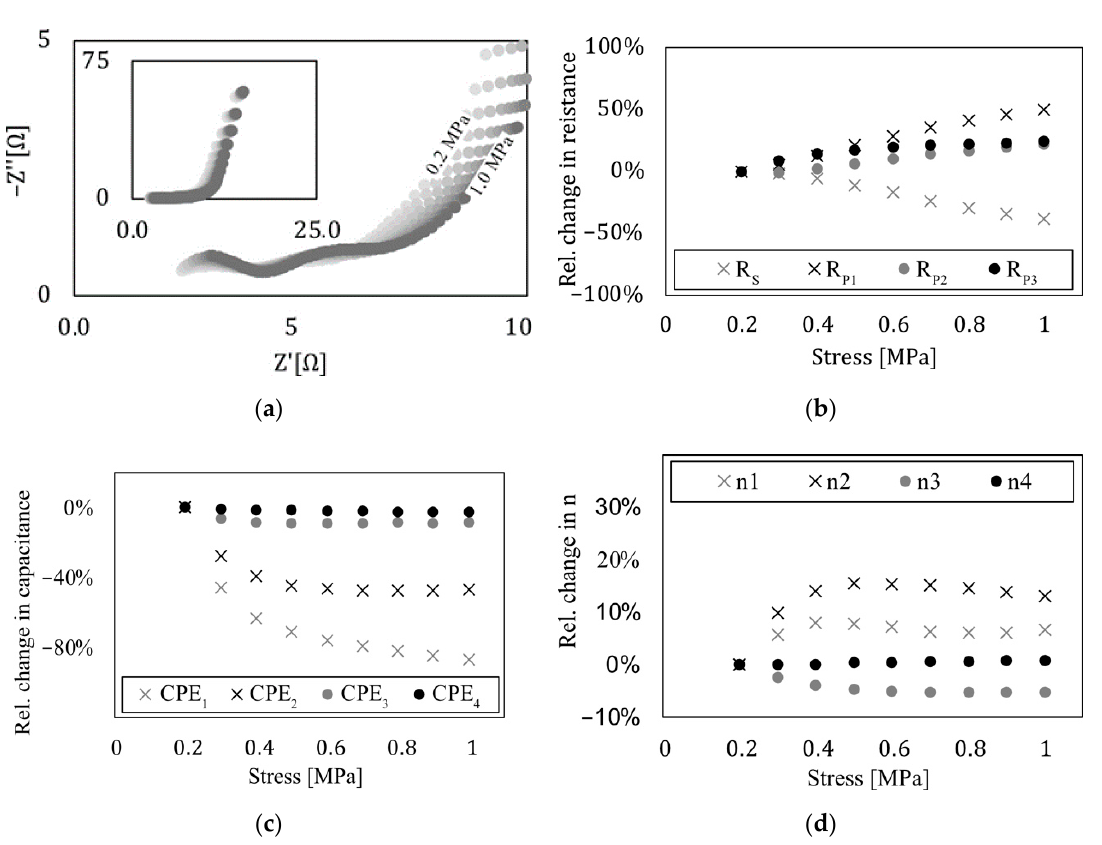
Figure 6. Electrochemical impedance in relation to perpendicular mechanical pressure ( a ) Results from the EIS due to mechanical pressure. ( b ) CPE n obtained from fitting. ( c ) Resistance obtained from fitting. ( d ) Exponent of the CPE obtained from fitting.